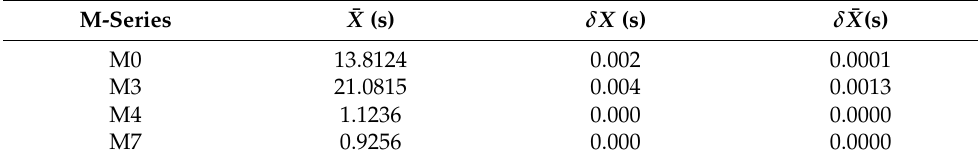
Table 1. ECDSA execution time.